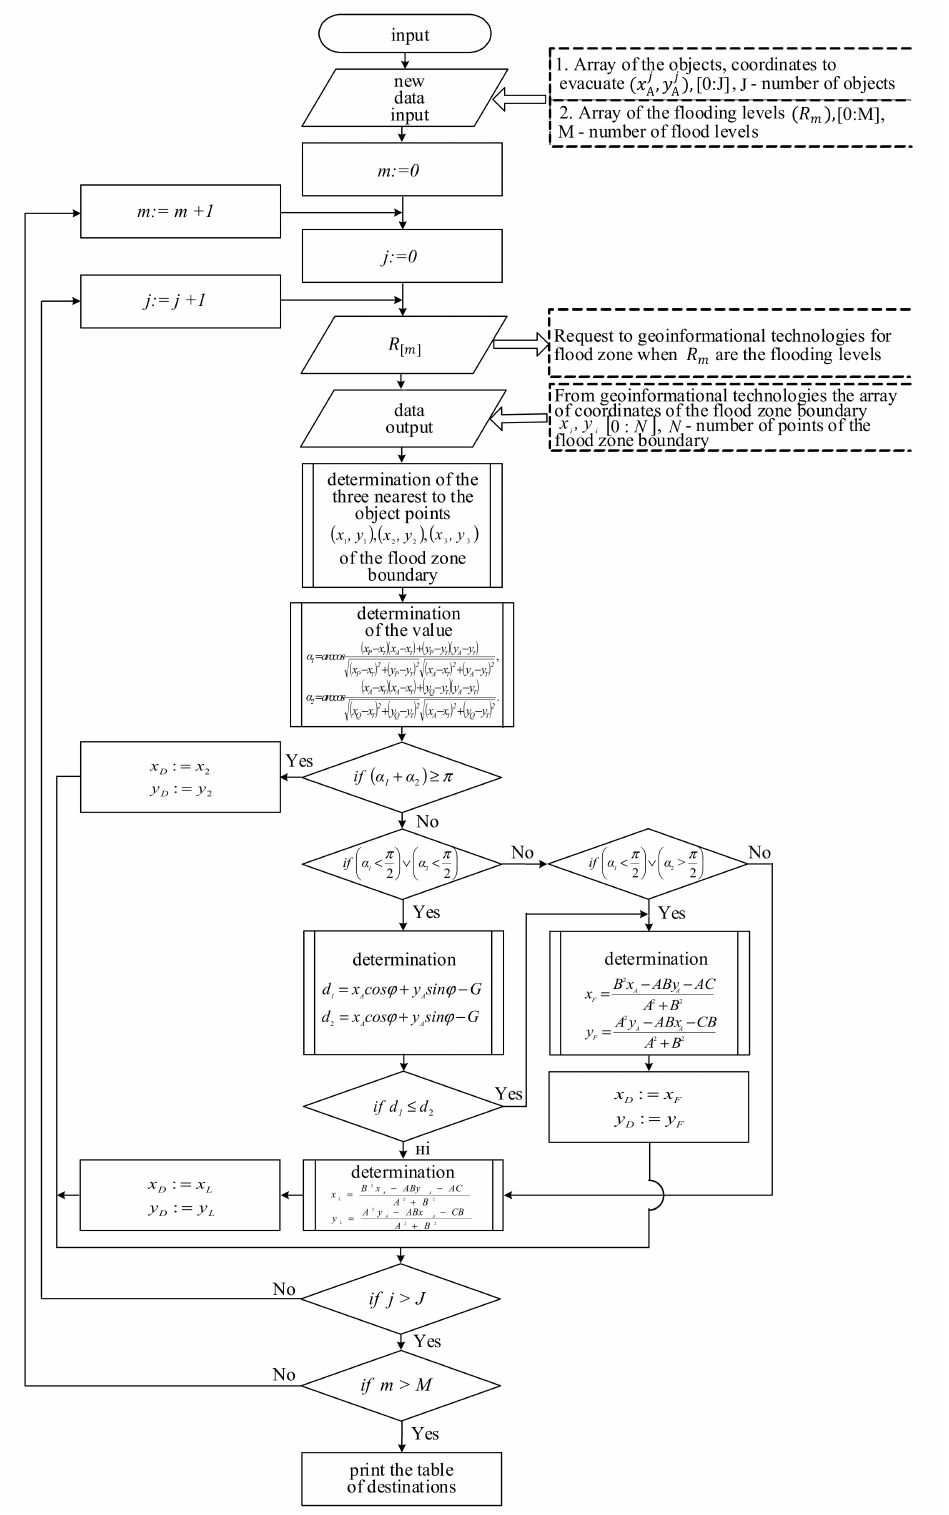
Figure 7. Flowchart of the methodology used to define the closest point of the flood